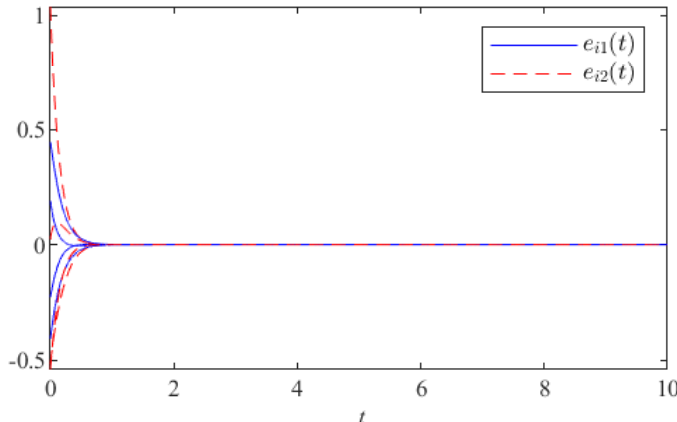
Figure 6. The system error e i ( t ) of MAS with boundary coupling (5) in Example 2.